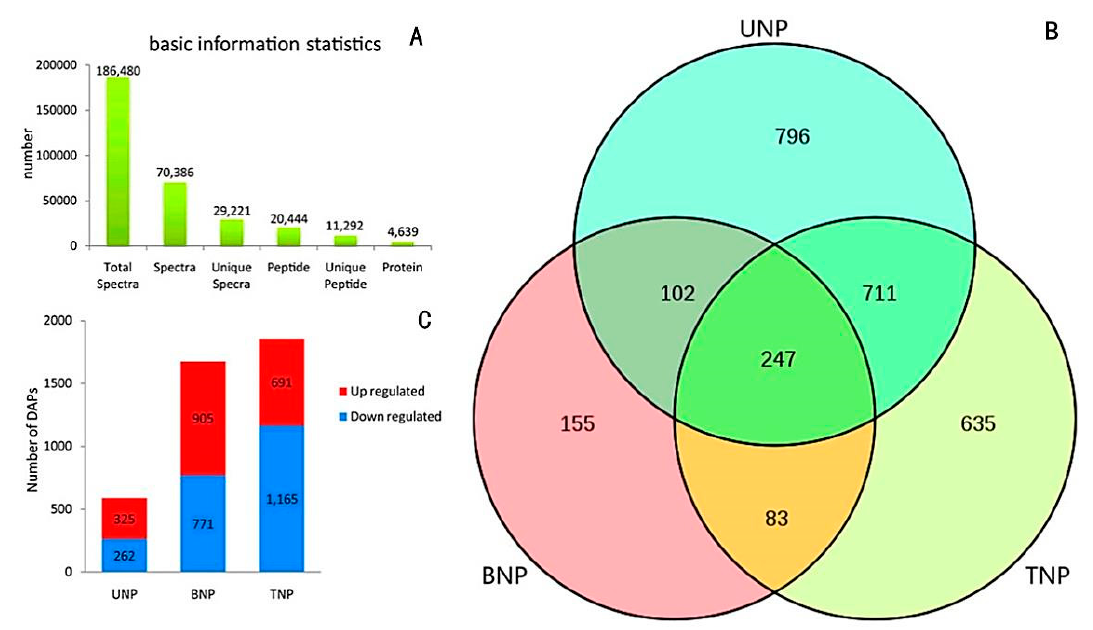
Figure 3. ( B ) Venn diagram; ( A , C ) accumulation histogram comparing the differentially abundant proteins (DAPs) in AS and AF. The numbers of DAPs are shown in the different stages. ( A ) Basic statistics; ( B ) Venn diagram of the DAPs in the three stages; ( C ) histogram showing the numbers of increased or decreased DAPs in the three stages (UNP, uninucleate stage; BNP, binucleate stage; and TNP, trinucleate stage).